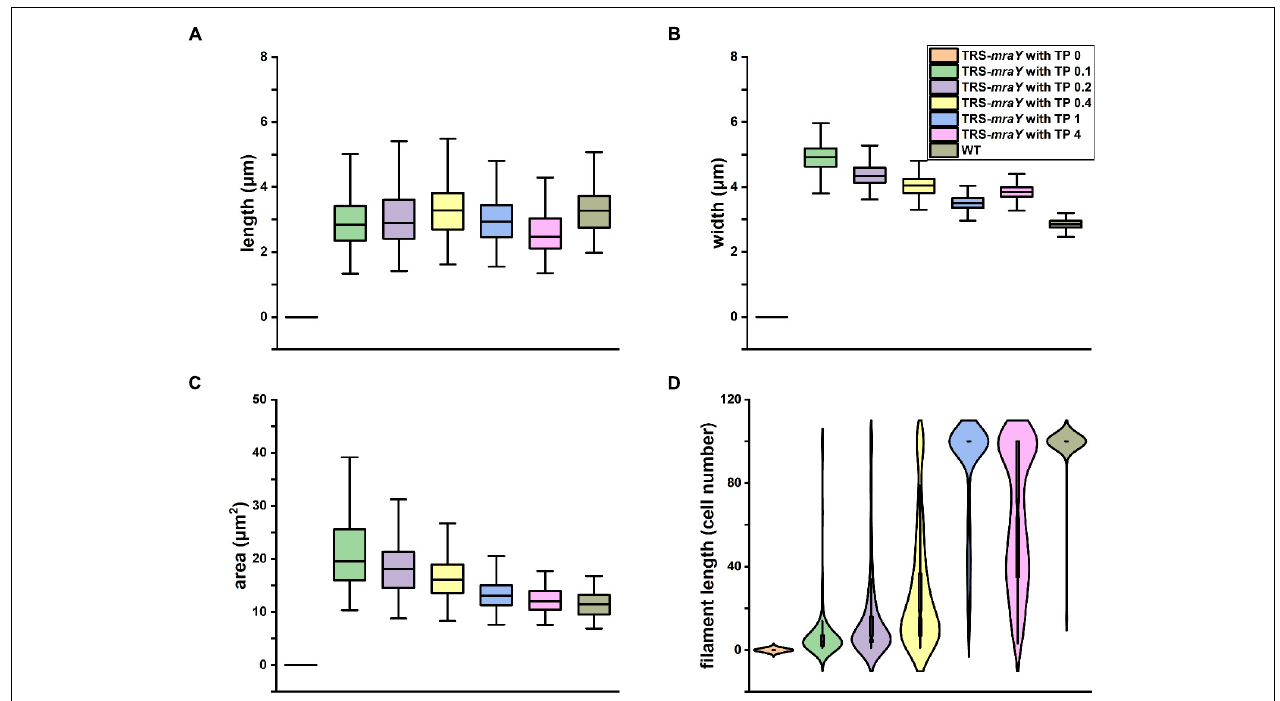
FIGURE 4 | Effects of mraY in filament integrity and cell morphology. WT and TRS- mraY mutant incubated for 4 days with different concentrations of TP were analyzed for cell length (A) , cell width (B) , cell area or volume (C) , and filament length (D) . 400 cells were measured for cell length and width, 300 cells for cell area, and 300 filaments were analyzed for filament length. In the latter case, filaments with 100 cells include those with more than 100 cells per